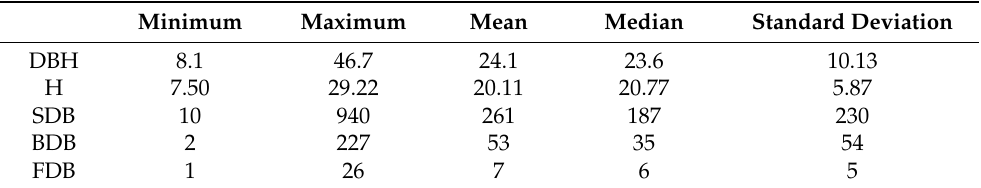
Table 2. Diameter at breast height (DBH, cm), tree height (H, m), stem dry biomass (SDB, kg), branches dry biomass (BDB, kg) and foliage dry biomass (FDB, kg) of black locust sample